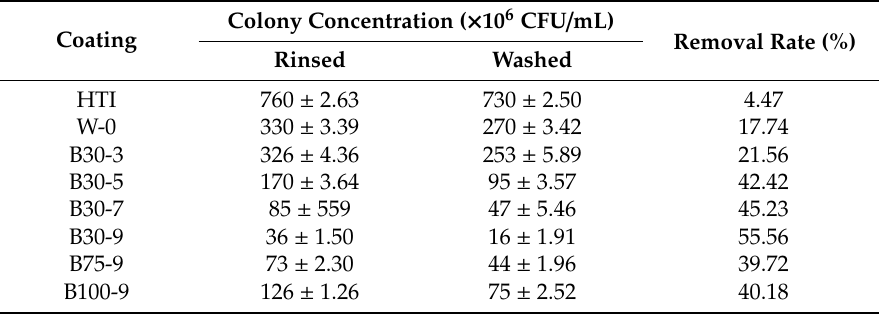
Figure 6. Image of bacterial colonies (different amounts of PSO added). Table 5. Amounts of colonies and fouling removal rate.